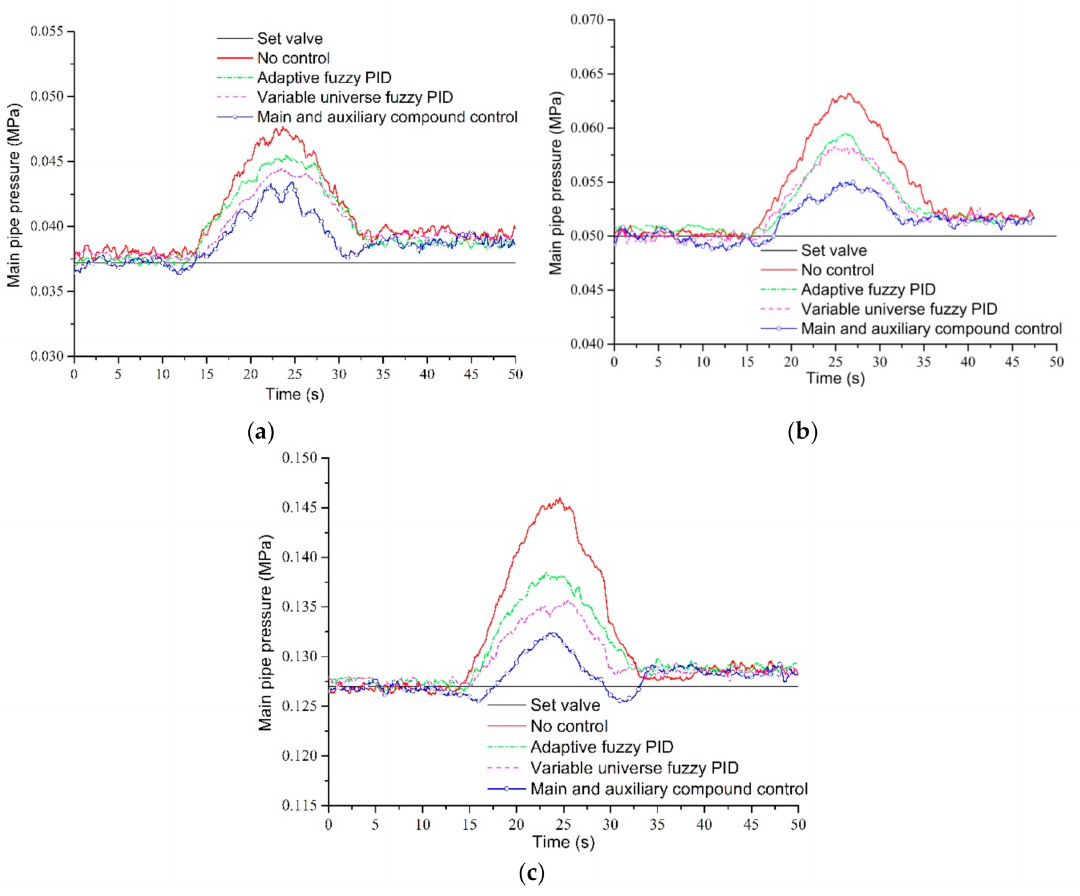
Figure 16. Pressure change curve of main pipe with smooth switching under di ff erent loads: ( a ) Load simulation ball valve opening 100%; ( b ) Load simulation ball valve opening 75%; ( c ) Load simulation ball valve opening 50%. Table 7. Maximum deviation rates of main pipe pressures of di ff erent control methods during the switching